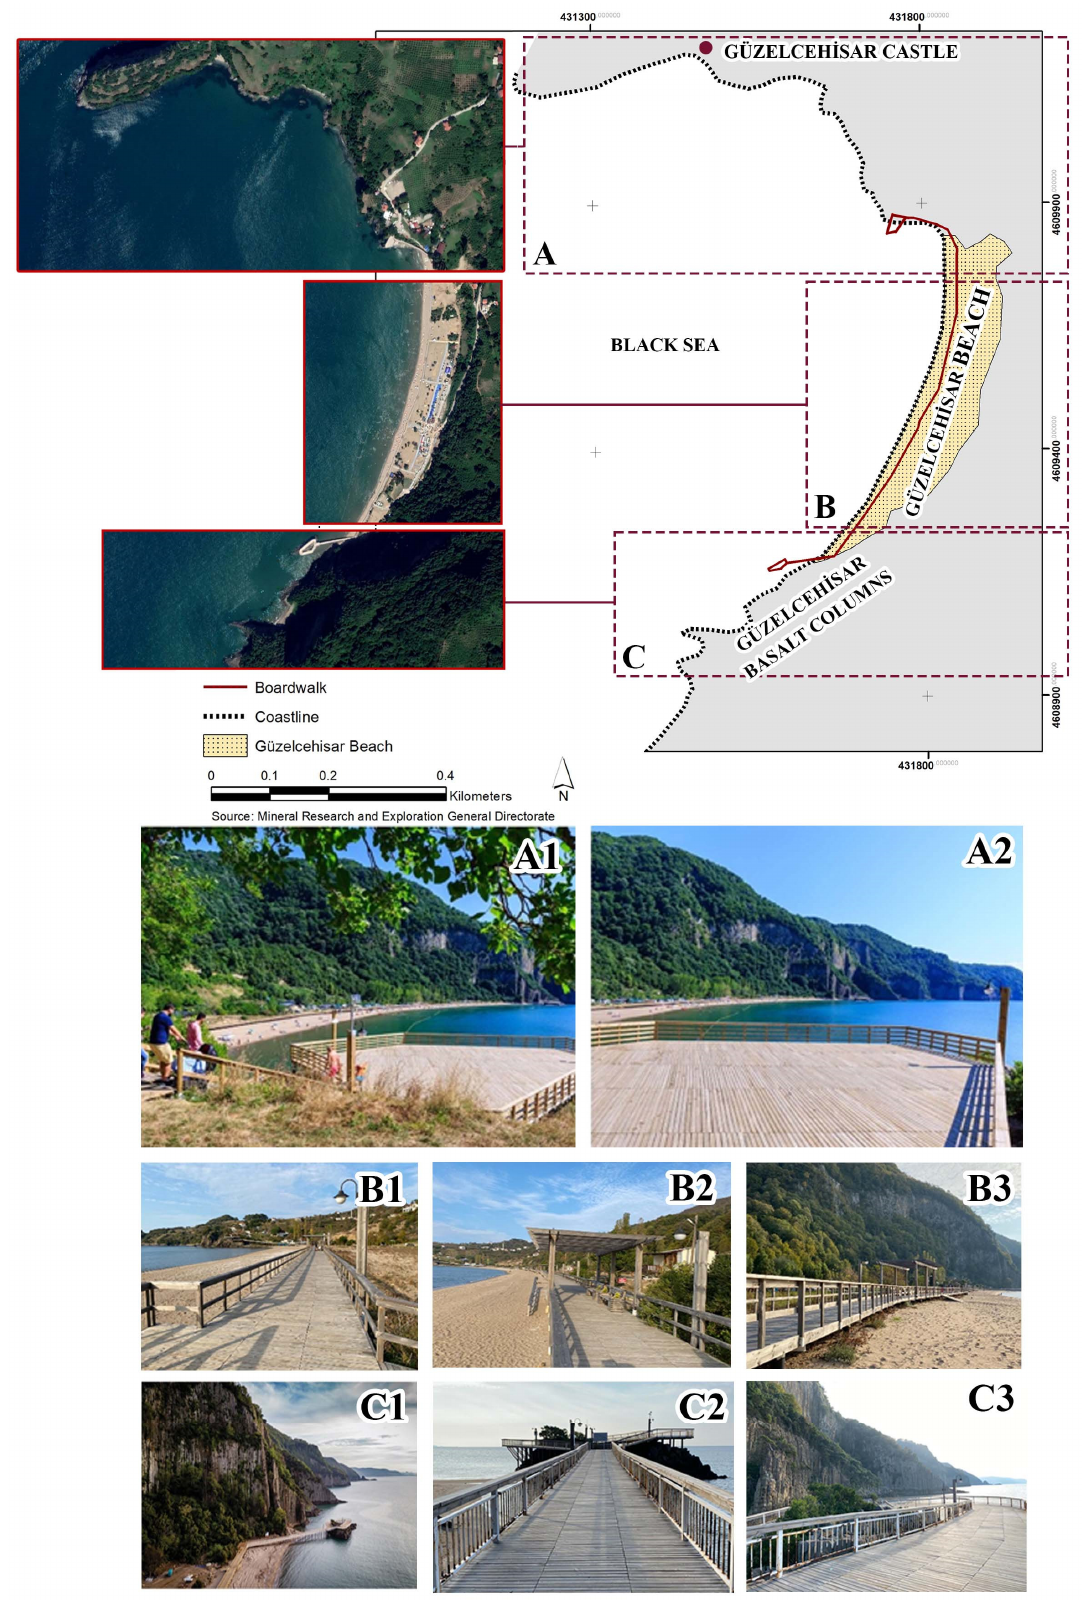
Figure 2. Güzelcehisar Beach Boardwalk. ( A1 , A2 ): Observation Terrace. ( B1 – B3 ): Beach Boardwalk. ( C1 – C3 ): Boardwalk beach-rocky island connection and observation terrace. (( A1 , A2 , C1 ), Source: [42]. ( B1 – B3 , C2 , C3 ), Source: Author’s work).